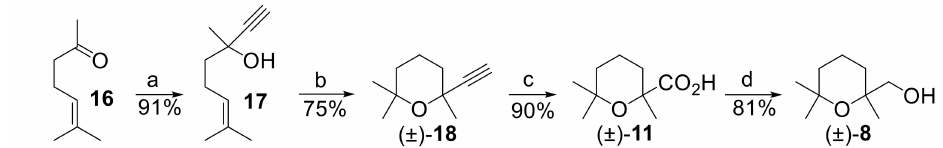
Figure 5. Synthesis of racemic 2,6,6-trimethyltetrahydro-2 H -pyran-2-yl)methanol 8 starting from 6-methylhept-5-en-2-one 16